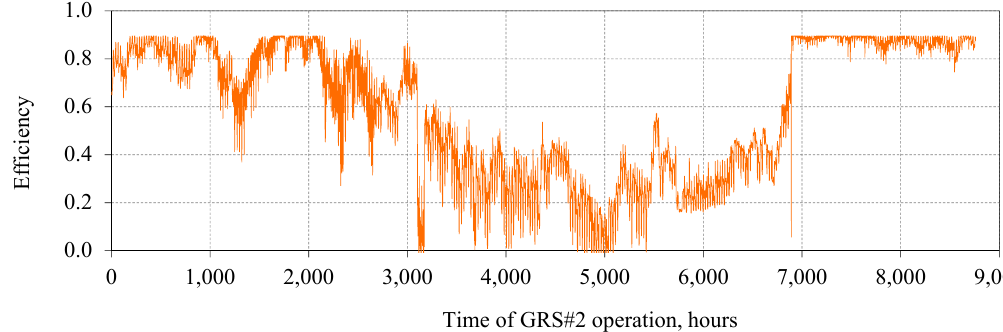
Figure 10. Generated electrical energy and heat demand at GRS #2 over a period of one year.